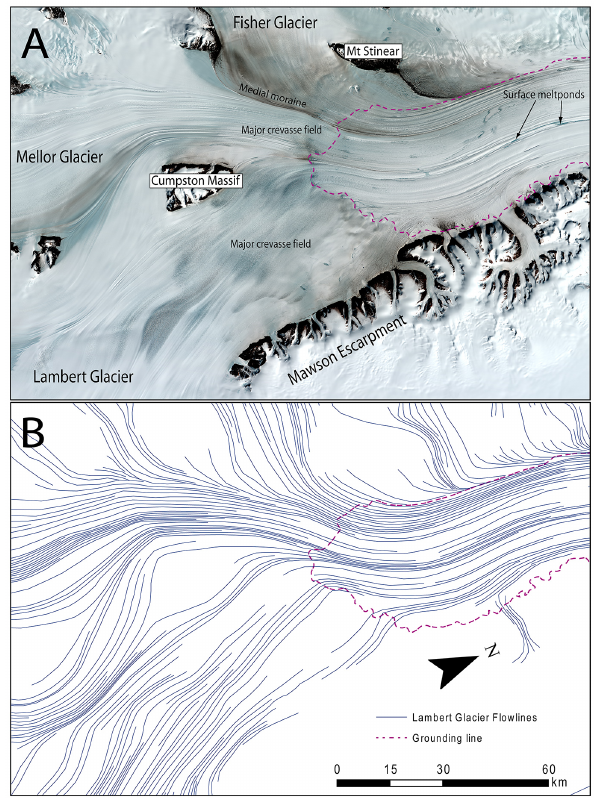
Figure 5. The confluence of the Lambert, Mellor and Fisher glaciers in East Antarctica: (a) Landsat image and (b) structural in- terpretation. Note that the longitudinal ice-surface structures pass uninterrupted through major crevasse fields and into an area domi- nated by surface ablation with visible surface melt ponds. The lon- gitudinal ice-surface structures could not persist through crevasse fields and could not survive in areas of glacier surface melt unless they are three-dimensional structures.